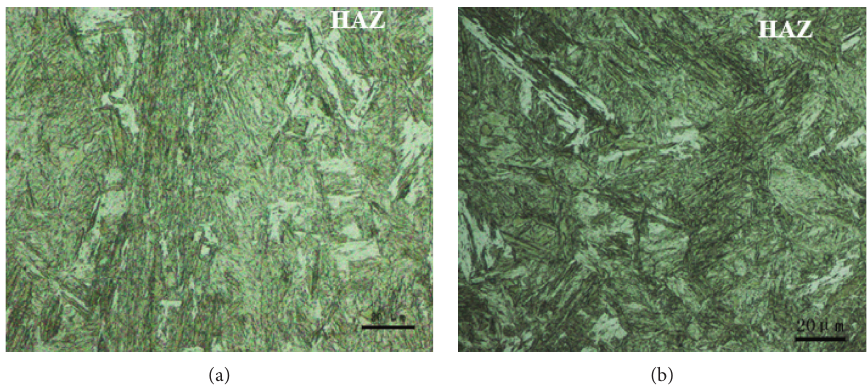
Figure 6: Coarse columnar grains. (a) QP980 steel RSW; (b) TRIP800 steel RSW.